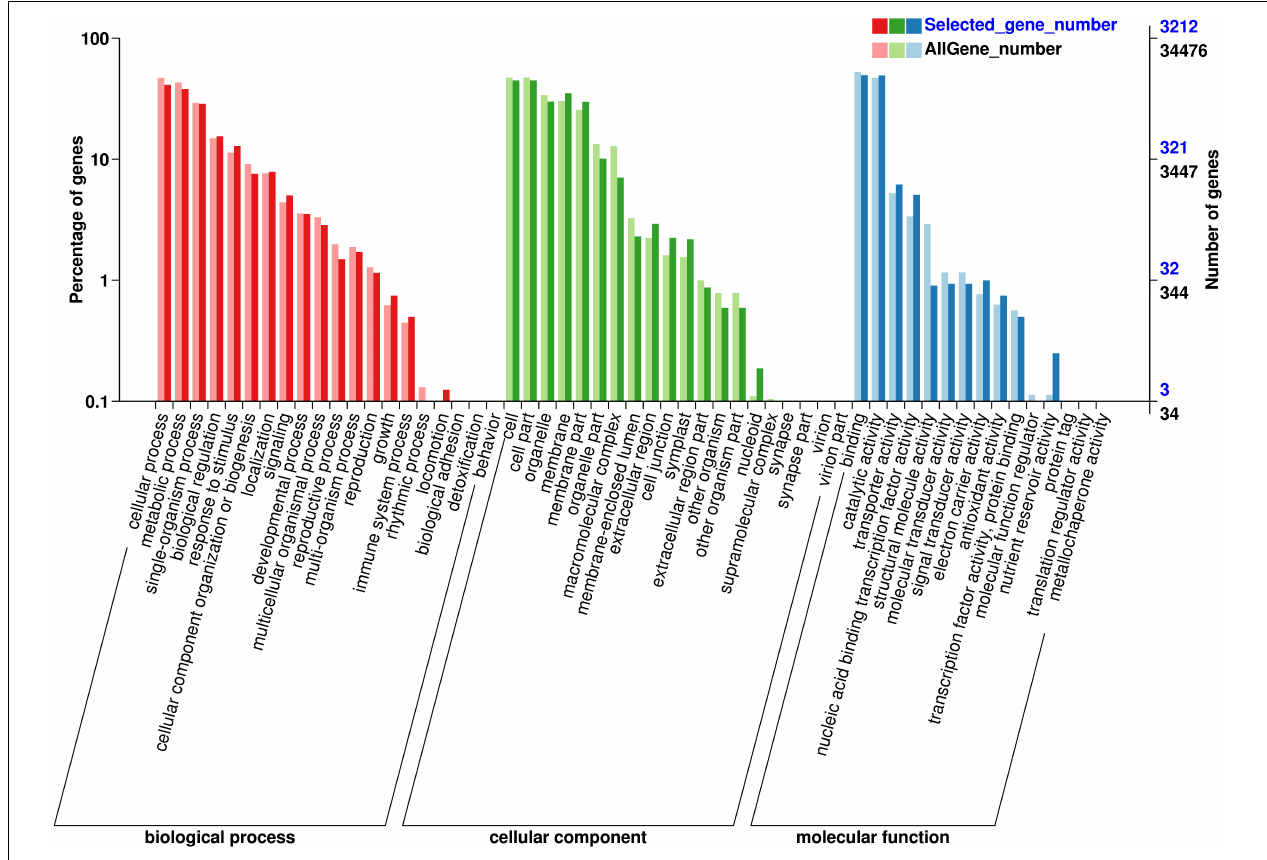
FIGURE 5 | GO classifications of DEGs of 62\3 and JB231AC under 50 µ M Cd stress.